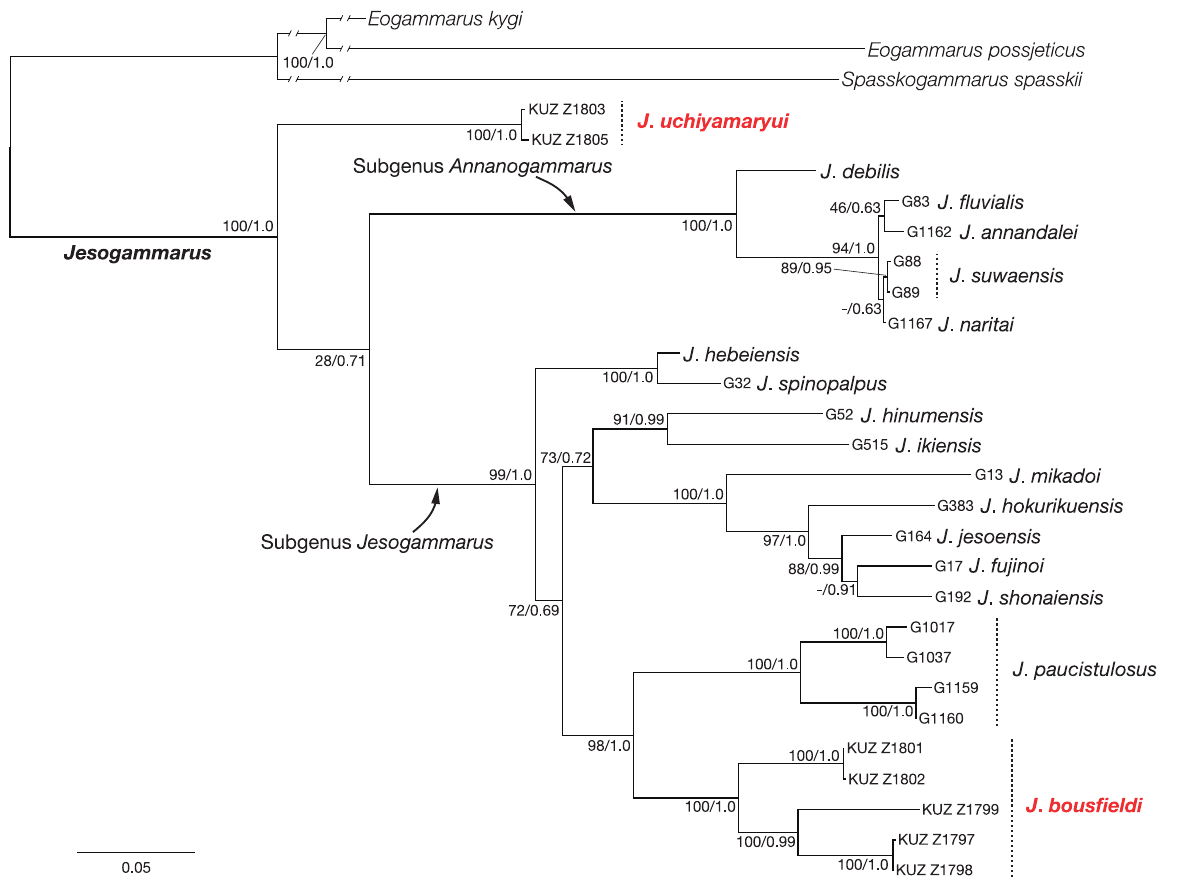
Figure 15. Bayesian inference tree for 1,499 bp of nuclear 28S rRNA and mitochondrial COI and 16S rRNA markers. Numbers on nodes represent bootstrap values for maximum likelihood and Bayesian posterior